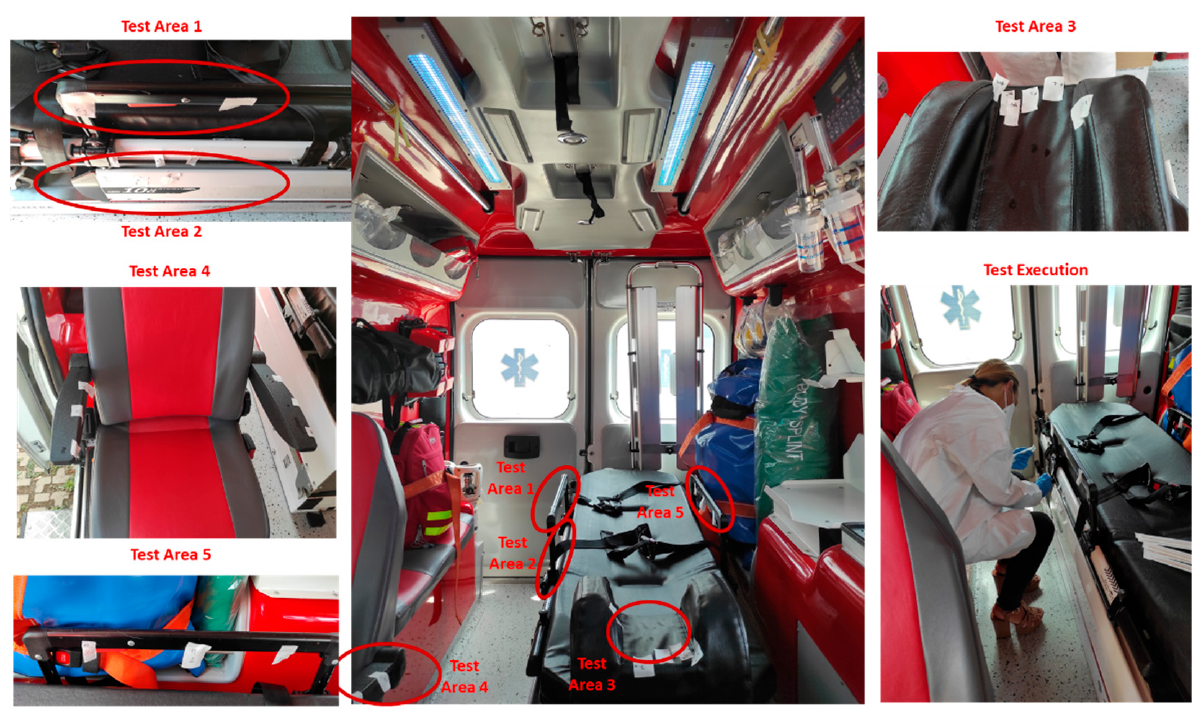
Figure 5. Test Execution on Ambulance during the Pilot phase.